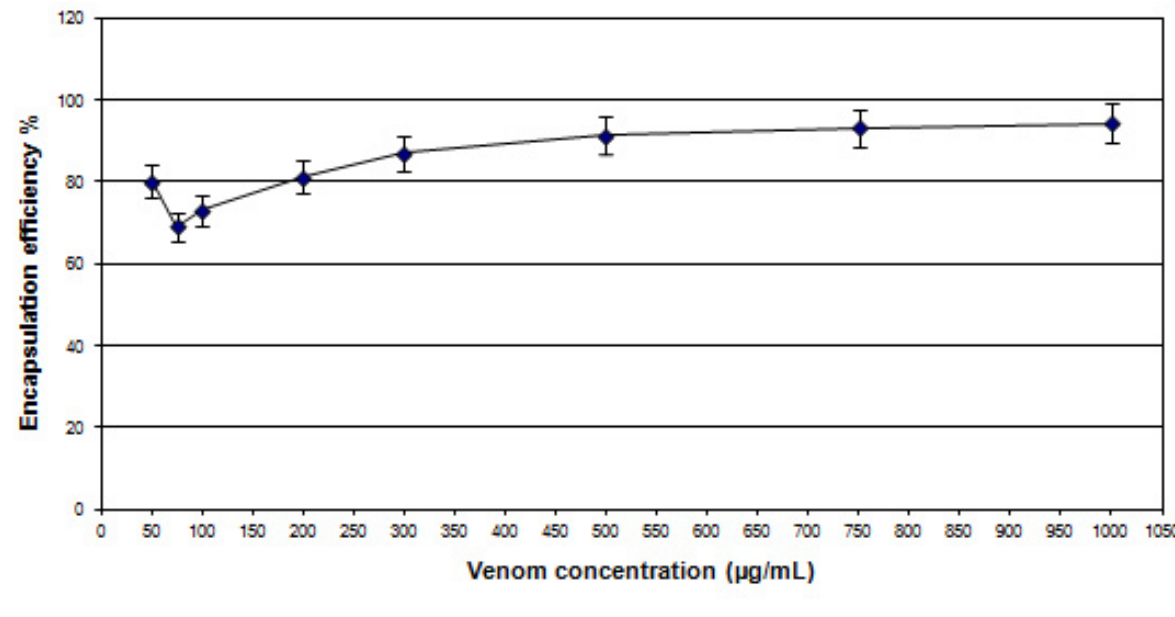
Figure 3. The influence of M. eupeus venom initial concentration on encapsulation efficiency (chitosan 2 mg/mL, TPP 1